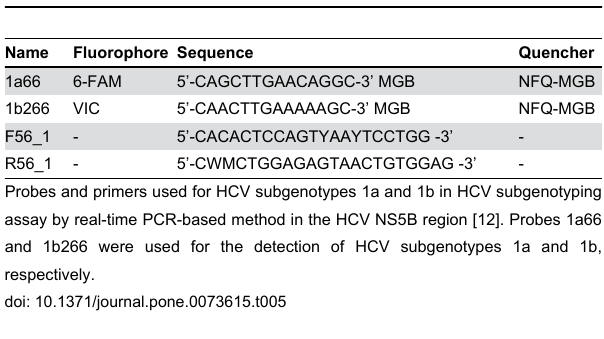
Table 5. Probes and primers used for real-time PCR-based method.